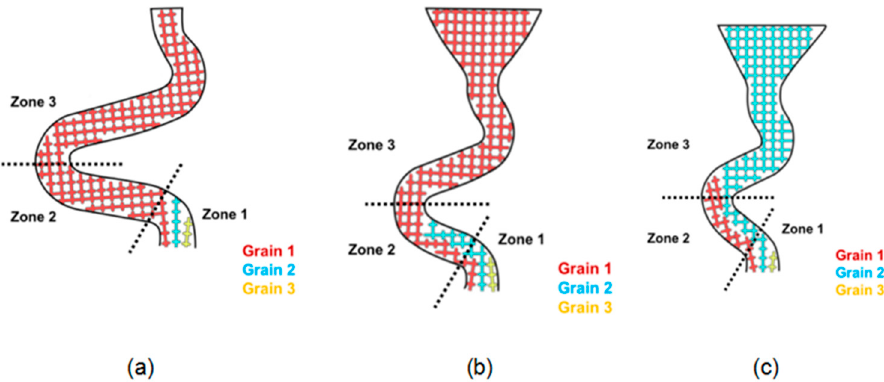
Figure 8. Grains (1, 2, and 3) growth and selecting in grain selectors varying in the take-off angle: ( a ) 15°, ( b ) 30°, and ( c ) 40°.